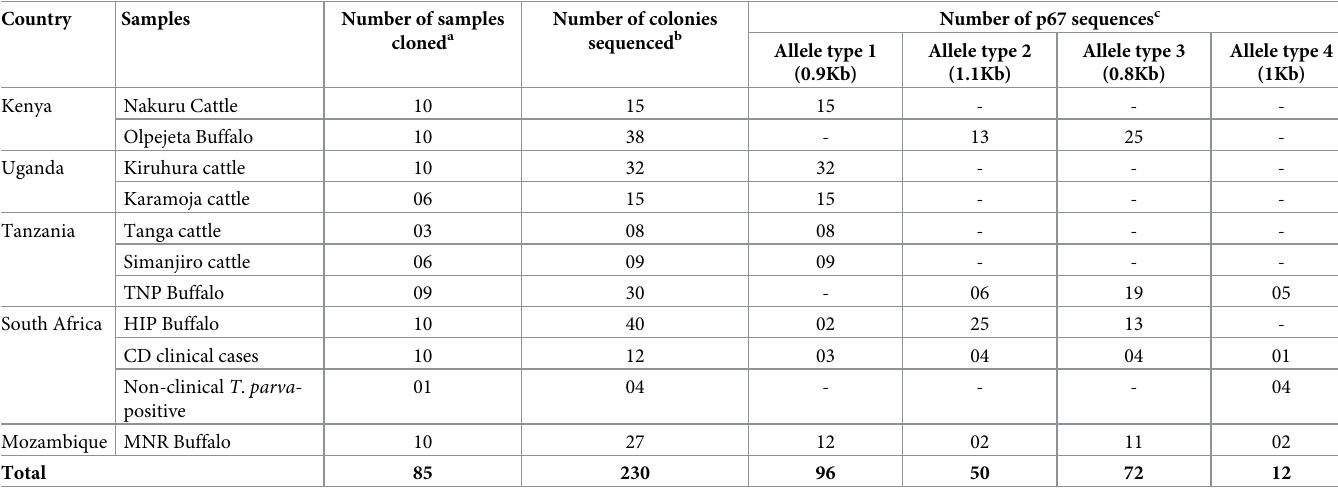
Table 3. p67 allele types from T . parva positive samples from East and southern Africa. Country Samples